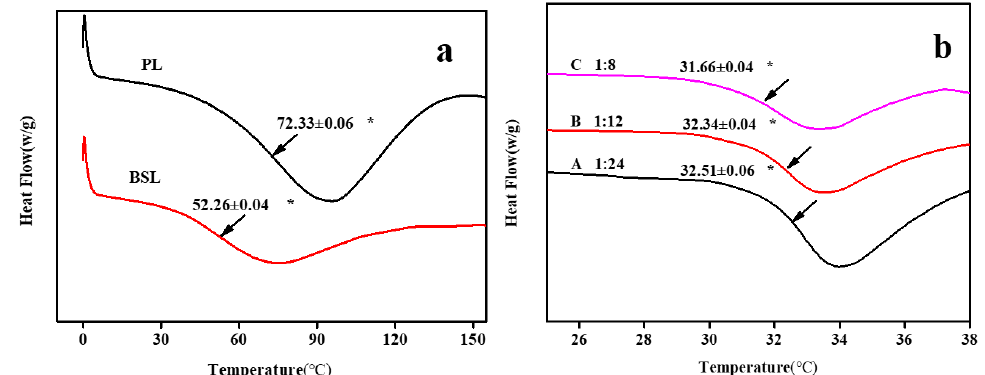
Figure 4. ( a ) Glass transition temperature ( T g ) of PL and BSL; ( b ) lower critical solution temperature (LCST) of gels; n = 3, mean values ± SD, * p < 0.01.